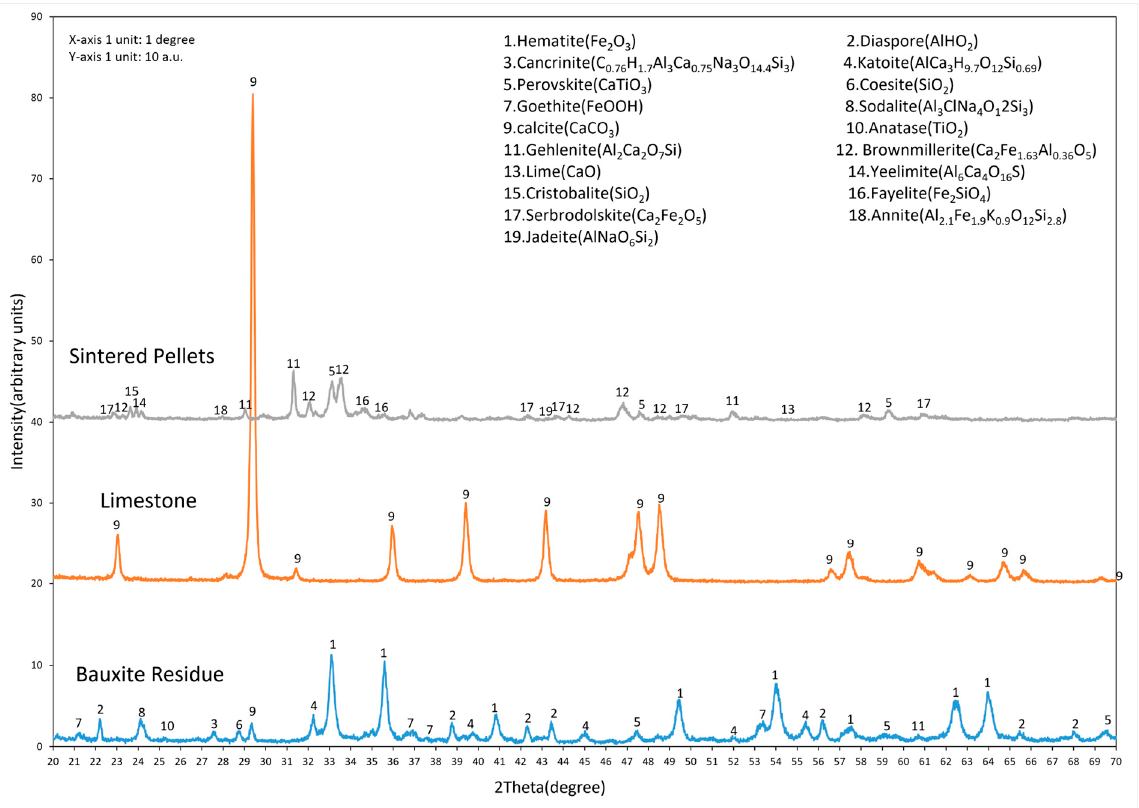
Figure 3. XRD analysis of bauxite residue, limestone and sintered pellets.